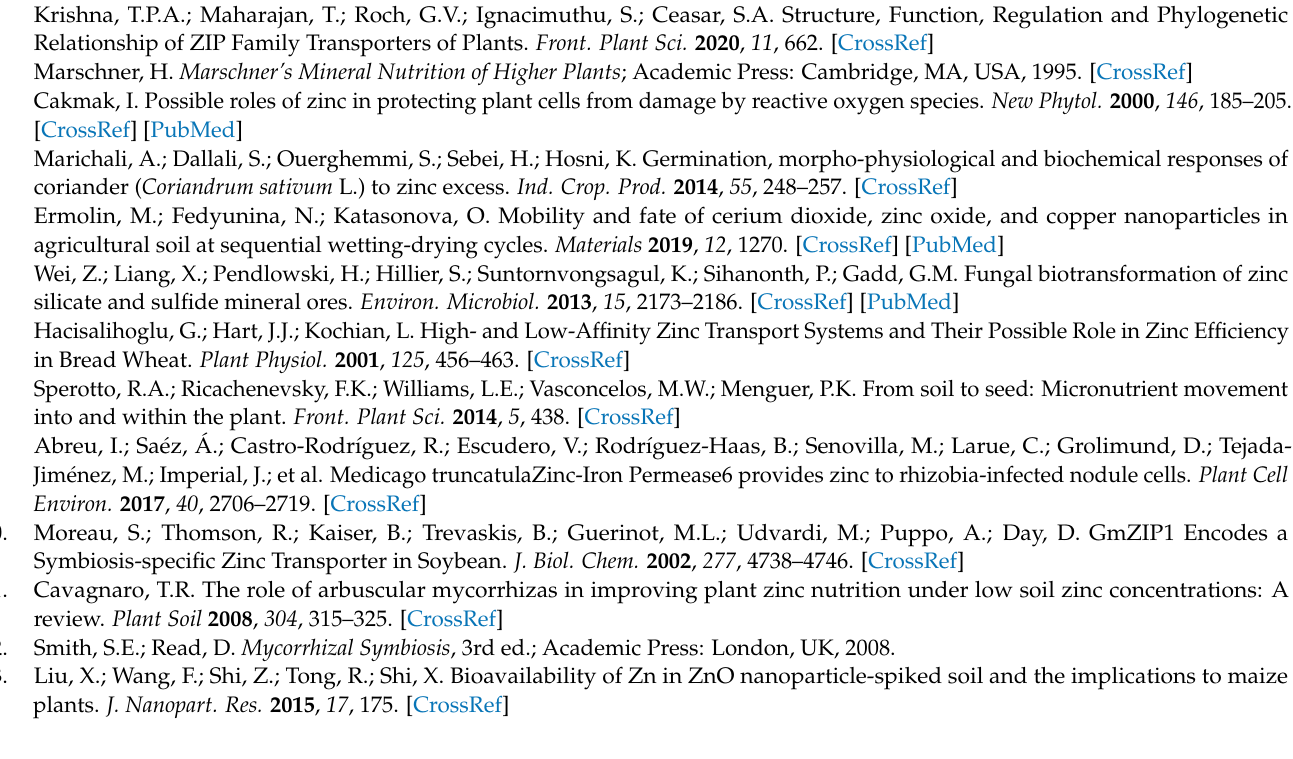
mycorrhizal symbiosis in A. sinicus . Figure S2. Gene structure and topology analysis of A. sinicus AsZIP2 . Figure S3. The P1BS-motif is present in the promoters of the AsZIP2 from A. sinicus as well as the ZIP2 subfamily genes from other plant species. Figure S4. Transcription of the arbuscular mycorrhiza-specific AsPT4 in mycorrhizal roots of A. sinicus in response to Pi and Zn availabilities. Figure S5. Transcription profiles of AsZIP2 in the roots and shoots of A. sinicus . Figure S6. Effect of external Zn concentrations on AM symbiosis in A. sinicus roots. Figure S7. Effect of AsZIP2 - overexpression ( AsZIP2-OE ) and AsZIP2 -silencing ( AsZIP2-RNAi ) on Zn concentration in roots of A. sinicus under standard growth conditions. Table S1. A list of the primers used in this study. Table S2. The accession numbers of the plant ZIP family proteins used in this